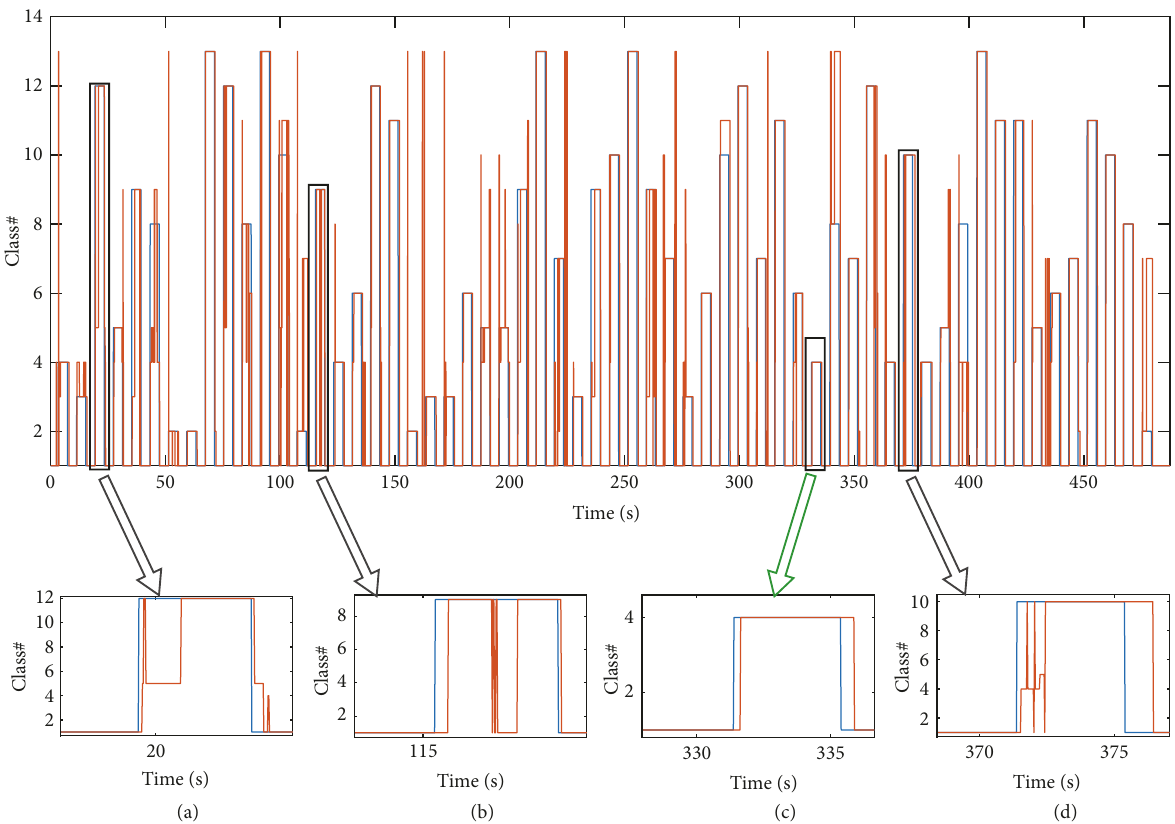
Figure 9: Sample classifications of the HSHMM. MAV (feature with the highest accuracies across all classifiers) and Subject 4 (median results).